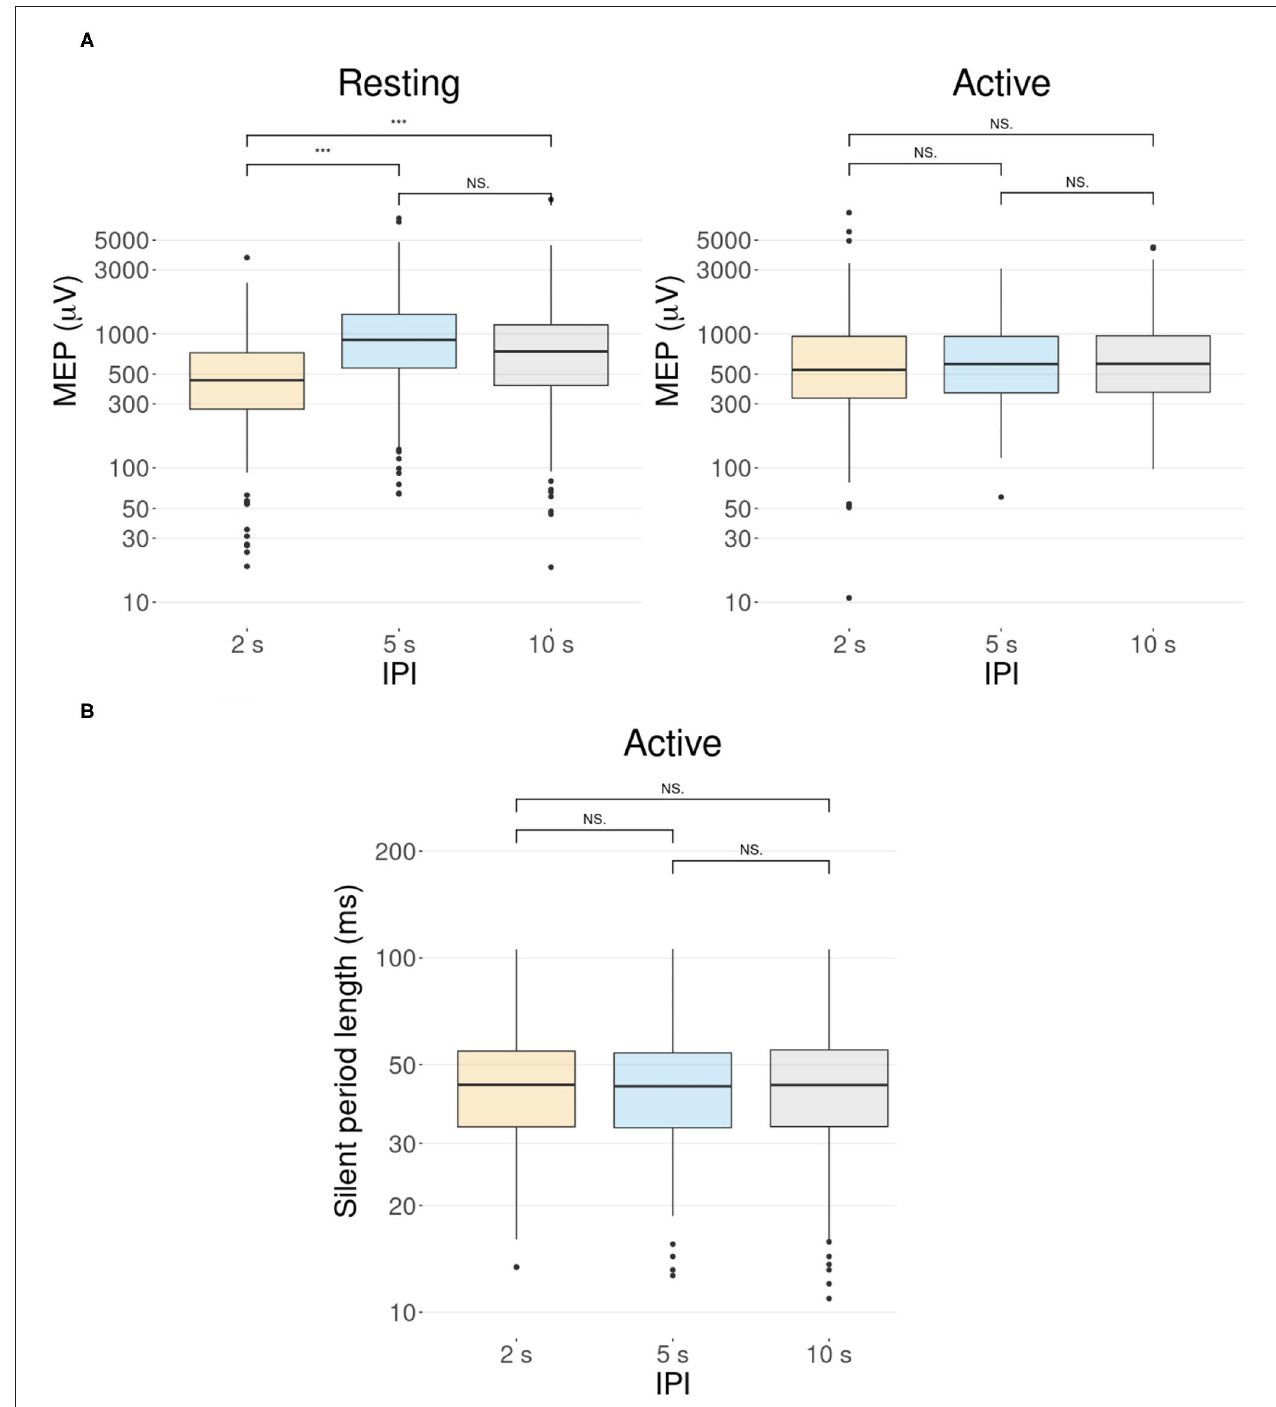
FIGURE 4 | The effect of the IPI. Participant-specific intercepts have been removed from the data using a linear mixed effects model. Graphs represent the minimum, maximum, median, first quartile, and third quartile in the data set on a logarithmic scale. *** p ≤ 0.001, Ns, non-significance. (A) Pulses after the first pulse (pulse numbers 2–30) show a difference in the MEP amplitudes in the resting condition but not in the active condition. In the resting condition, the MEP amplitude of the 2 s IPI differs significantly from those of the 5 and 10 s IPIs (p < 0.001). In the active condition, there is no significant difference between the MEP amplitudes of different IPIs (p > 0.1). (B) Boxplot illustration of the length of the silent period for different IPIs in the active condition. A Wilcoxon signed-rank test with a Bonferroni adjustment shows no support for significant differences between the different IPIs (all p = 1).